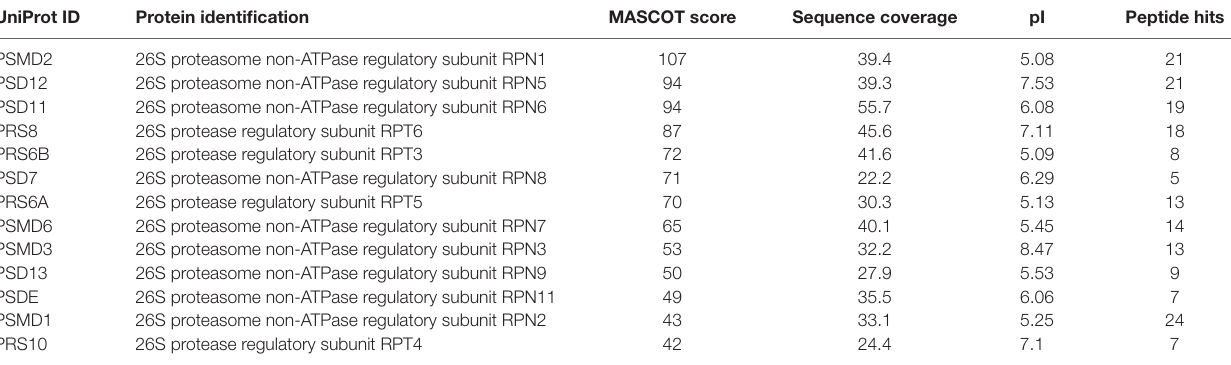
TaBle 1 | list and details of proteasome proteins identified by liquid chromatography–tandem mass spectrometry (lc–Ms/Ms). UniProt iD Protein